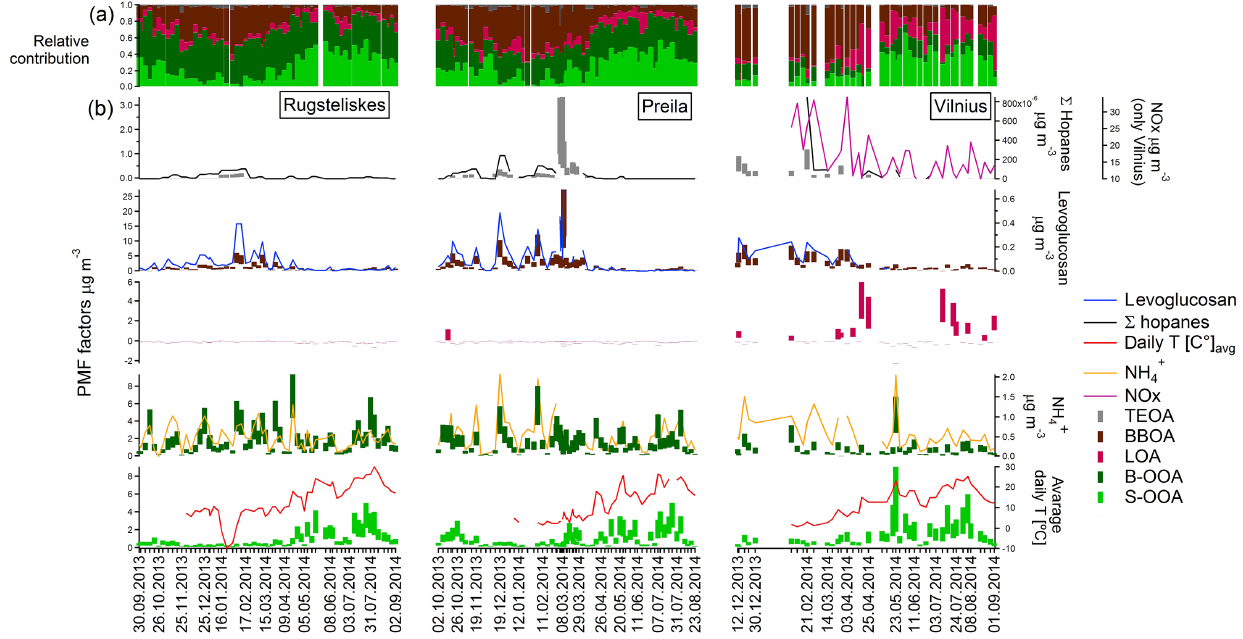
Figure 3. (a) Temporal evolutions of the relative contributions of the OA factors. (b) OA sources and corresponding tracers: concentrations and uncertainties (shaded areas). Table 2. Pearson correlation coefficients between non-combustion factors (other-OA components) from offline-AMS and marker source apportionment.